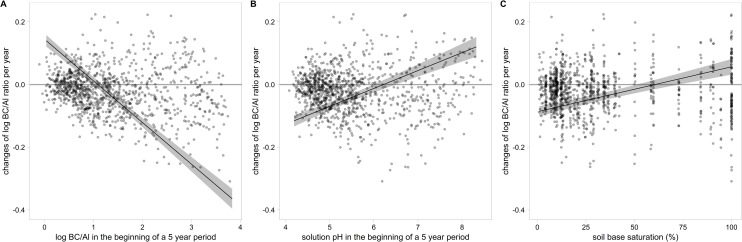
Rate of changes of BC/Al ratio within five years in relation to selected predictors from Table 4.Predicted values including 95% confidence intervals are conditioned on all other fixed effects. Negative changes signify an expected decrease in BC/Al. The linearity of the relations was tested using polynomial functions.